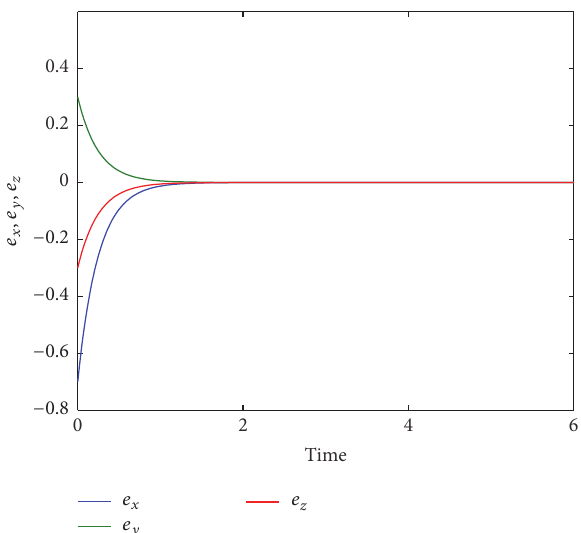
Figure 7: Time-history of the synchronization errors which indi- cates the synchronization between the master system and the slave